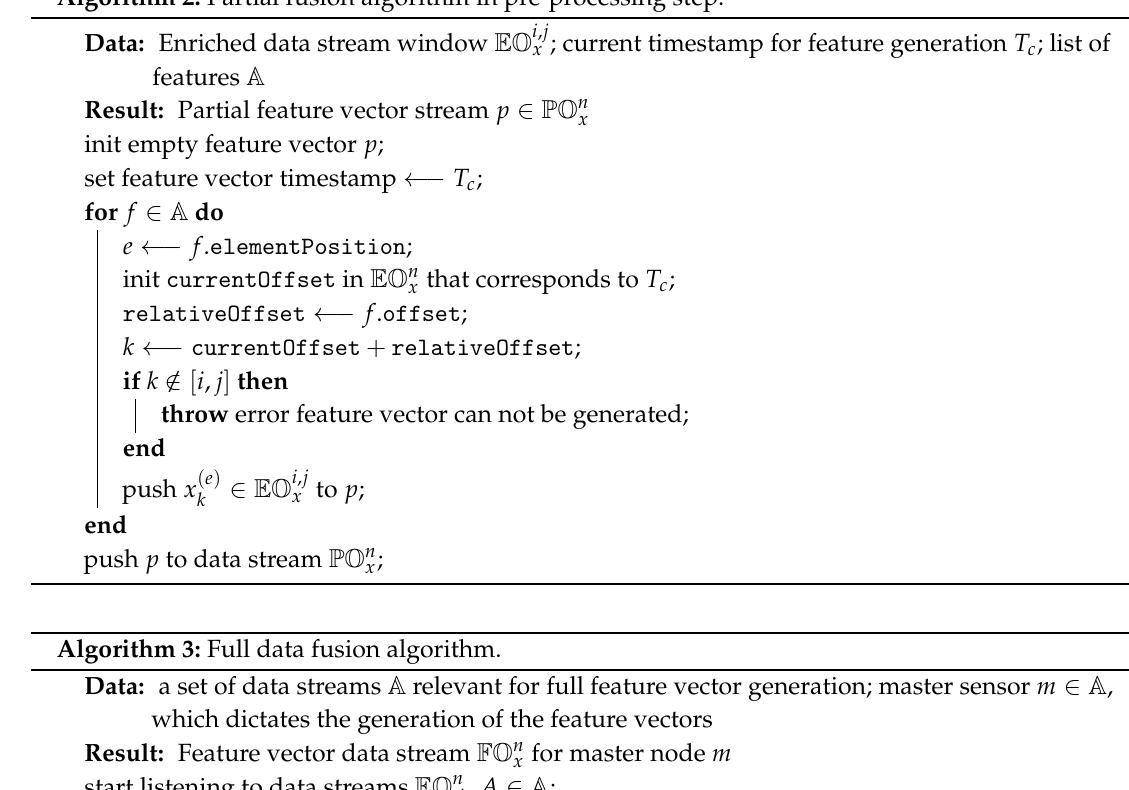
Algorithm 2: Partial fusion algorithm in pre-processing step.